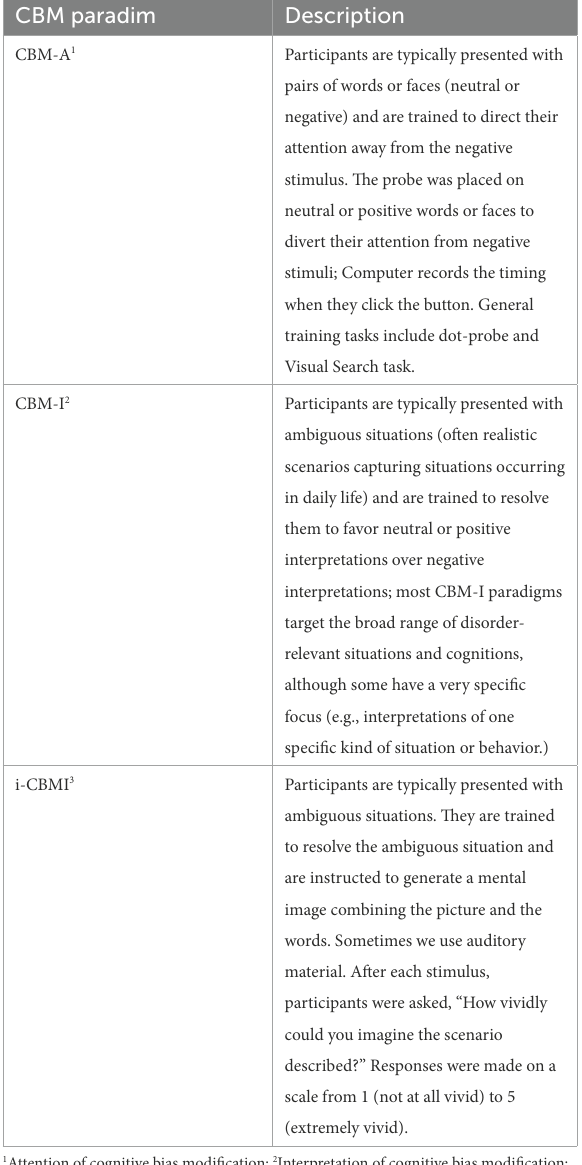
TABLE 1 Description of typical cognitive bias modification interventions. CBM